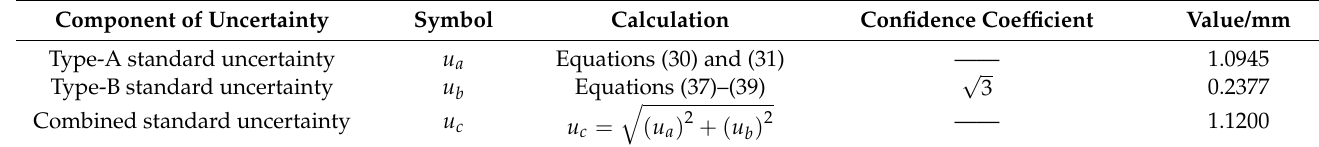
Table 9. The procedure budget about uncertainty of arc